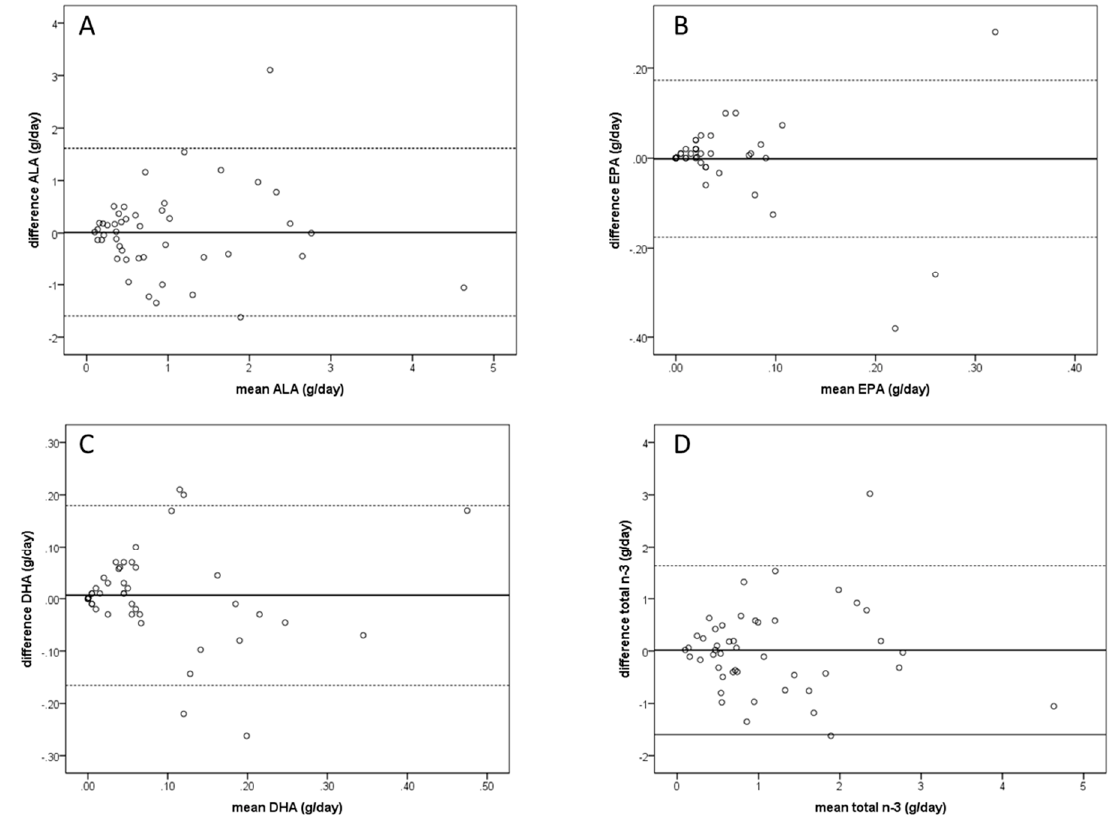
Figure 1. Bland Altman plots showing the agreement between 7-day food records and food frequency questionnaire to assess the intake of: ( A ) α -linolenic acid (ALA), ( B ) eicosapentanoic acid (EPA), ( C ) docosahexanoic acid (DHA), and ( D ) total n-3 polyunsaturated fatty acid intake (total n-3 ). The limits of agreement (dotted line) indicates the 95% confidence interval (mean ± 1.96 * SD).